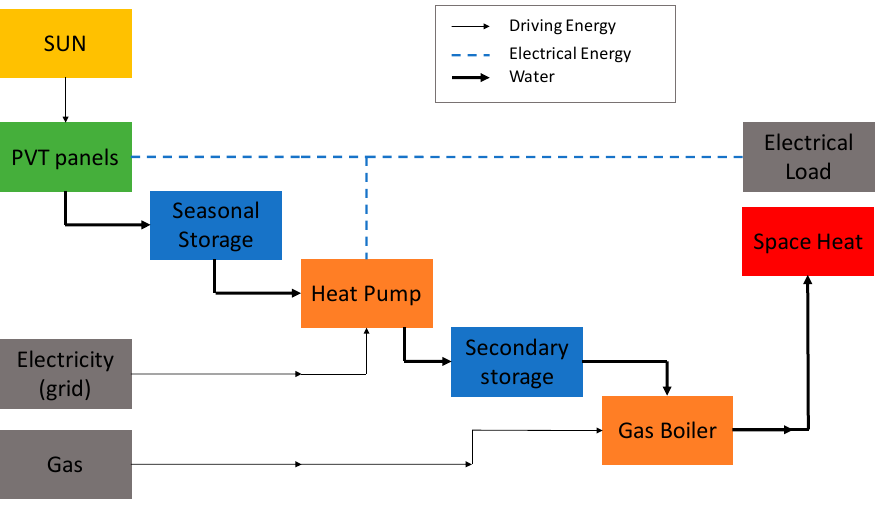
Figure 2. Basic schema of the energy system.